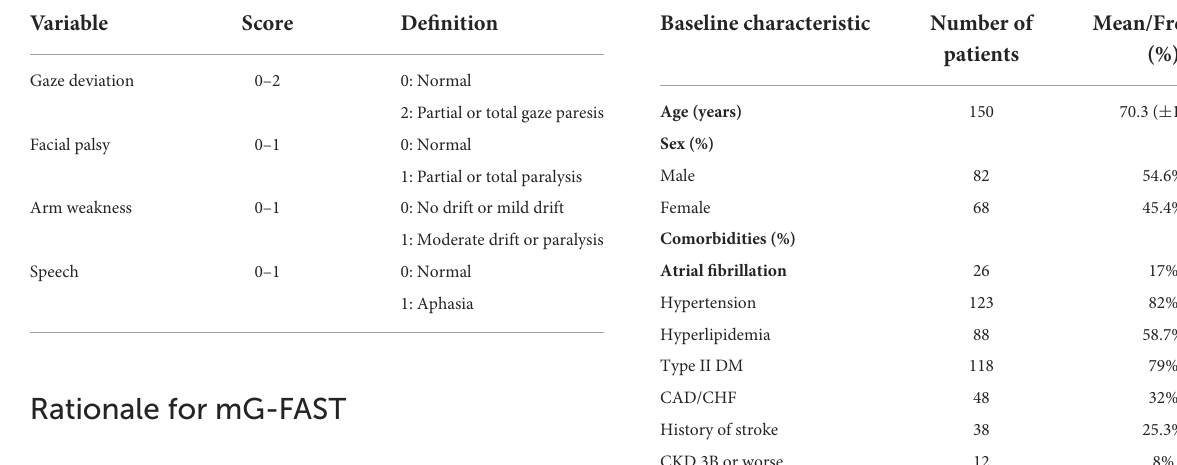
TABLE 2 Baseline characteristics of included patients.